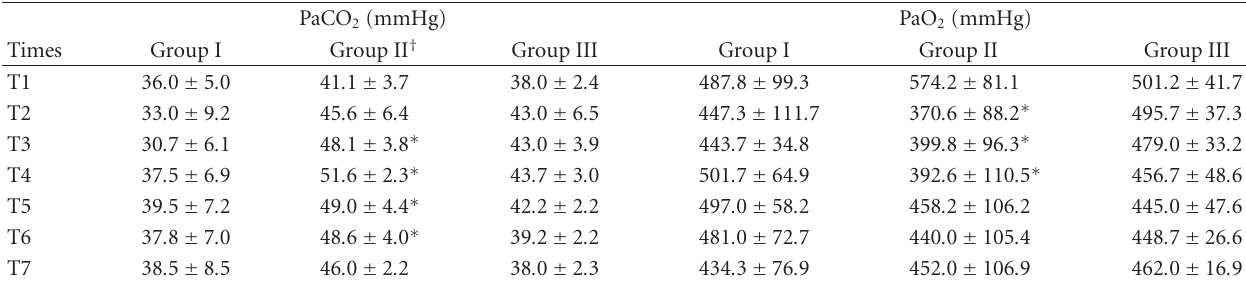
Table 5: Acid-base balance in pigs anesthetized with sevoflurane, fentanyl, and vecuronium and undergoing aortic cross-clamping through laparotomy (Group I) or laparoscopy with (Group II) or without aortic cross-clamping (Group III).